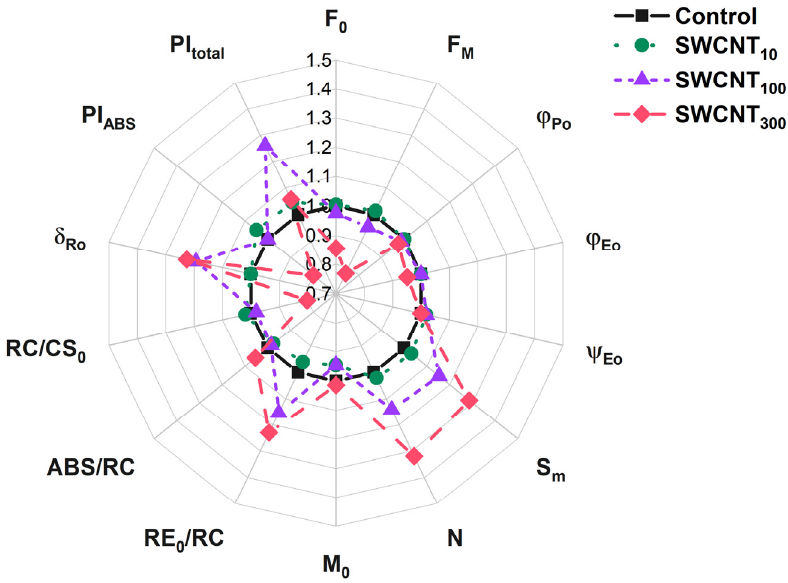
Figure 3. Selected JIP parameters for intact pea leaves treated with distilled water (control), 10, 100 or 300 mg/L of polymer-grafted SWCNT. The JIP parameters values were normalized to those of the control.